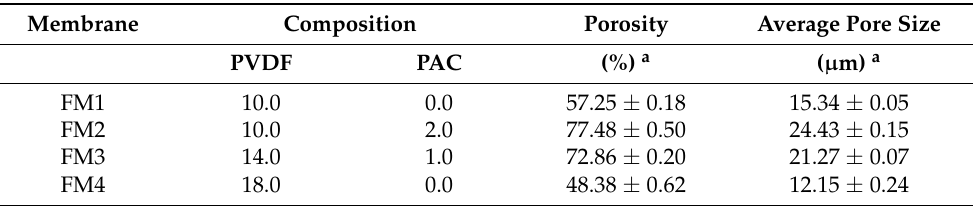
Table 6. Permeability measurements for selected fabricated PVDF-PAC membranes. Membrane